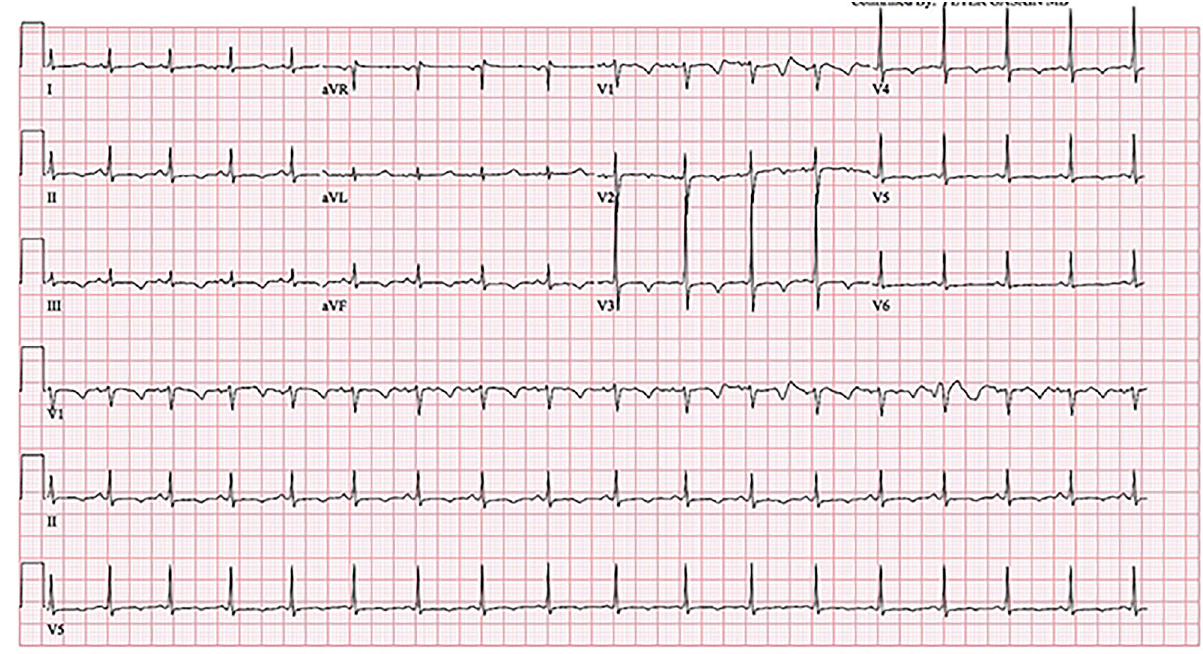
Image 1. Electrocardiogram of eight-year-old boy with new-onset